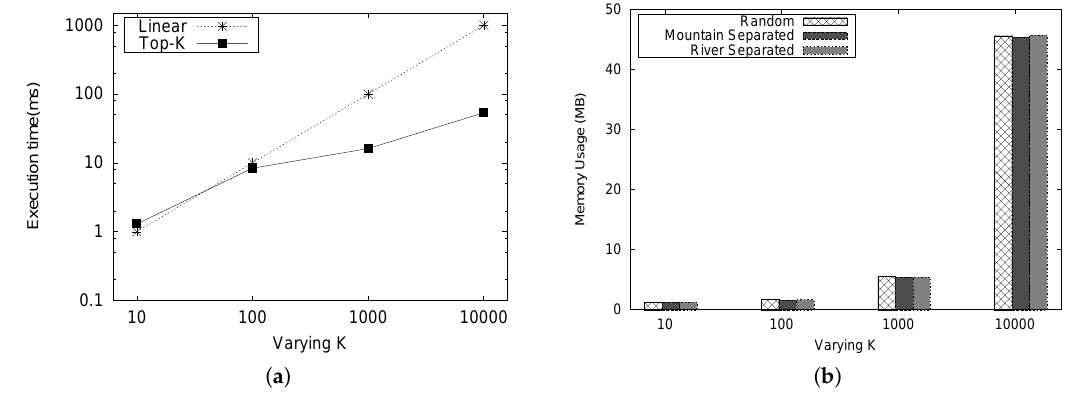
Figure 22. Top-K proximity computation. ( a ) execution time; ( b ) memory